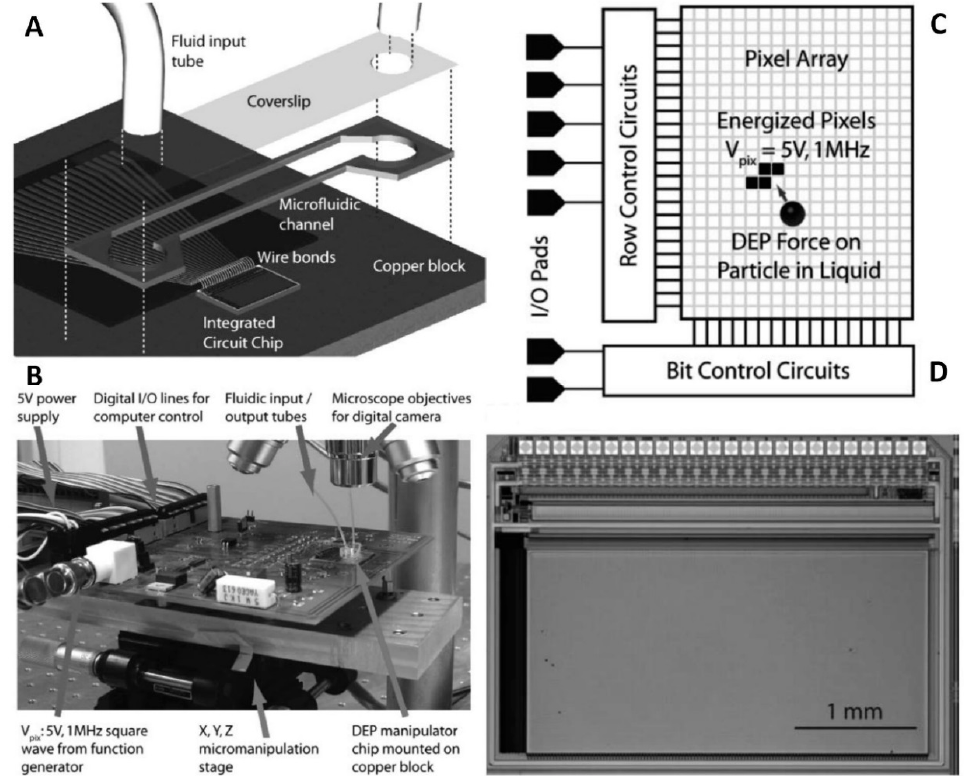
Figure 9. An integrated circuit (IC) DEP microfluidic system. Reproduced with permission from [79], © 2008 RSC. ( A ) Schematic of the device. ( B ) Photograph of the system. ( C ) The schematic of the IC electrodes. ( D ) Image of the IC electrodes.